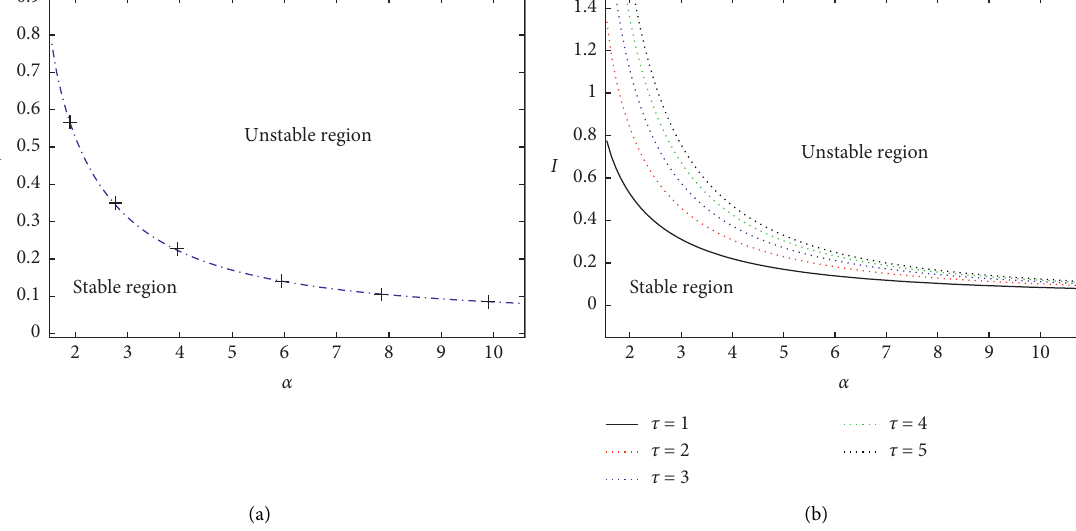
Figure 3: The two regions created by the Hopf bifurcation in the α − I and β − I planes: (a) the two-term solutions and (b) the outcomes for five different values of τ